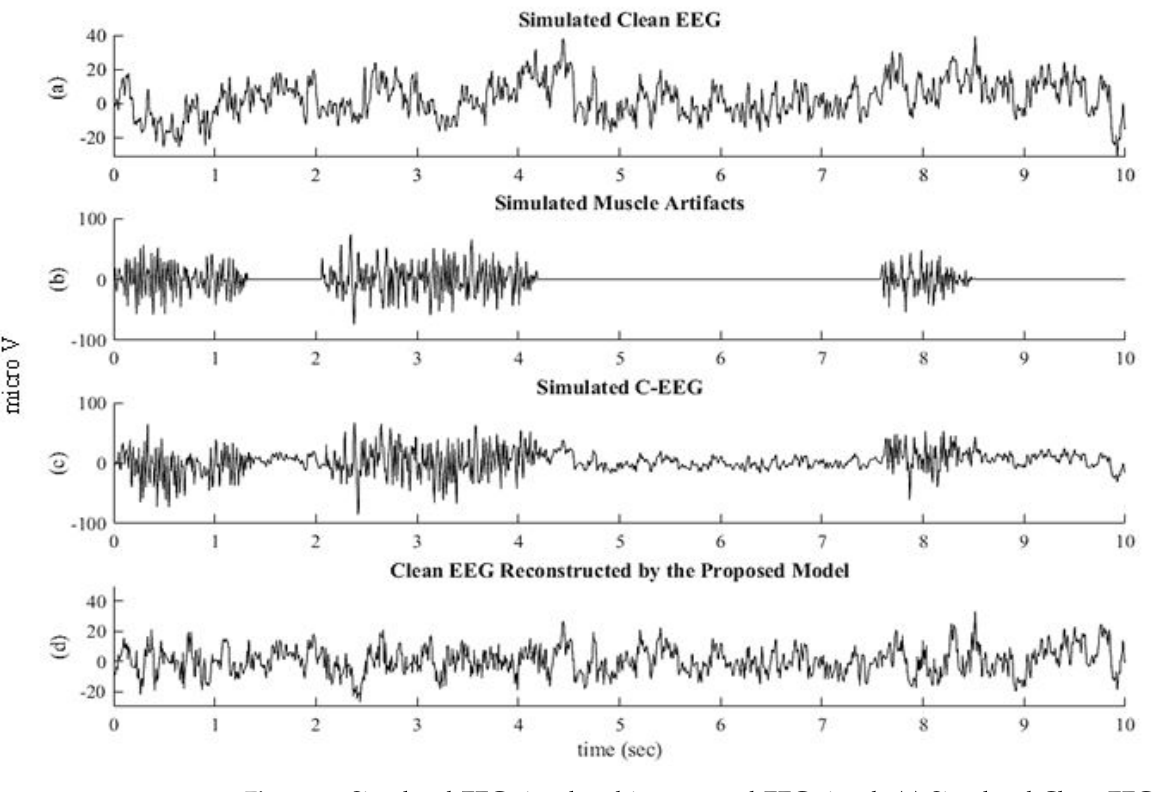
Figure 7. Simulated EEG signal and its corrected EEG signal: ( a ) Simulated Clean EEG Signal, ( b ) Simulated EMG Artifact Signal, ( c ) Simulated Corrupted EEG Signal, and ( d ) Clean EEG Recon- structed by the proposed model.